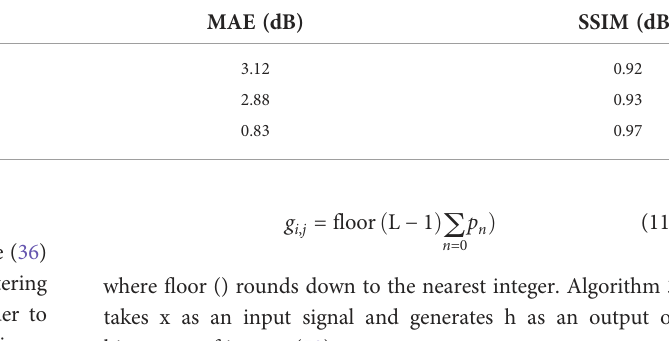
ALGORITHM 3 Histogram Equalization.